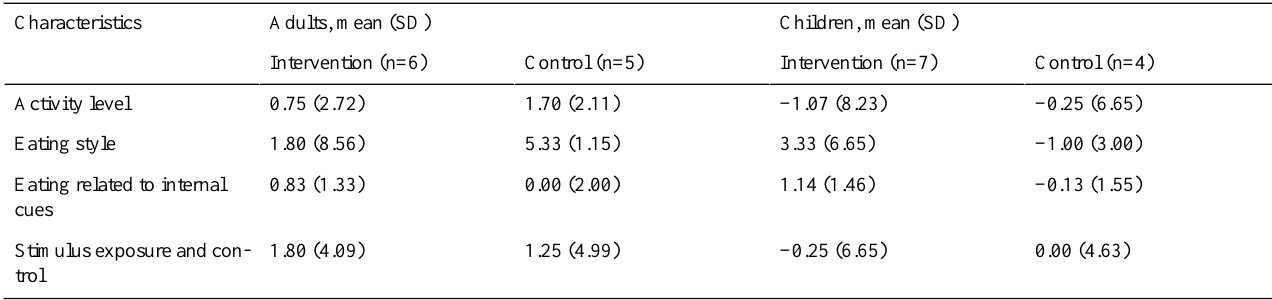
Table 4. Change in scores for Family Eating and Activity Habits Questionnaire for adults and children in phase